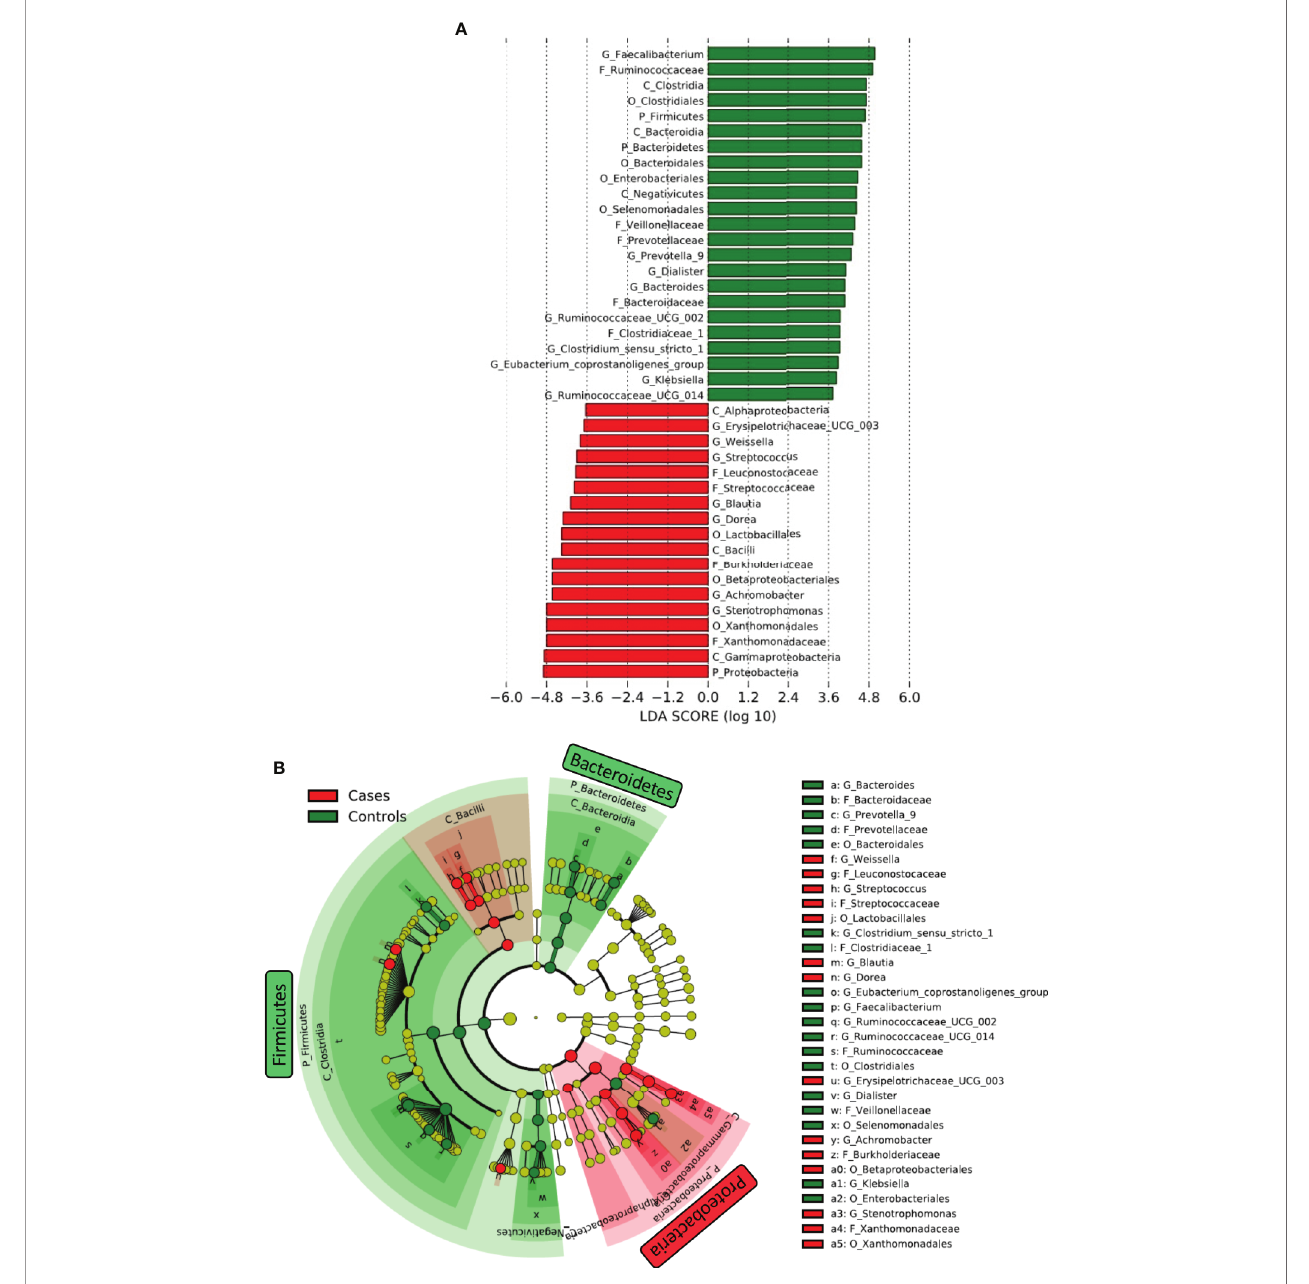
FIGURE 4 | Difference in abundant taxa in fecal microbiome between HIV-1 uninfected and infected Ghanaian adults. (A) Data determined by linear discriminant analysis (LDA) effect size (LEfSe). Alpha value of 0.01 and 3.6 threshold on the logarithmic LDA score for discriminative features was used. P_, C_, O_, F_, G_ represent Phylum, Class, Order, Family, and Genus, respectively. (B) Cladogram. Green and Red indicate HIV- (Controls) and HIV+ (Cases),